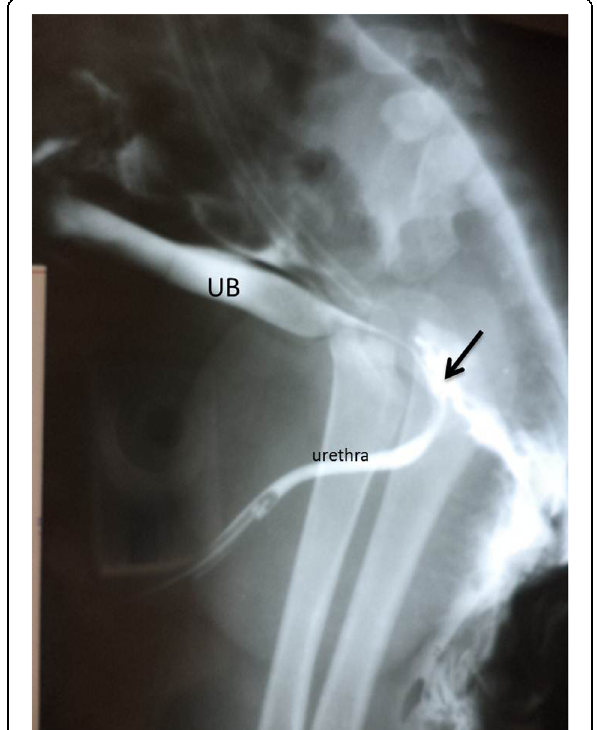
Fig. 19 Iatrogenic urethro-cutaneous fistula in an infant. Ascending cysto-urethrogram showing leakage of contrast at the site of the bulbar